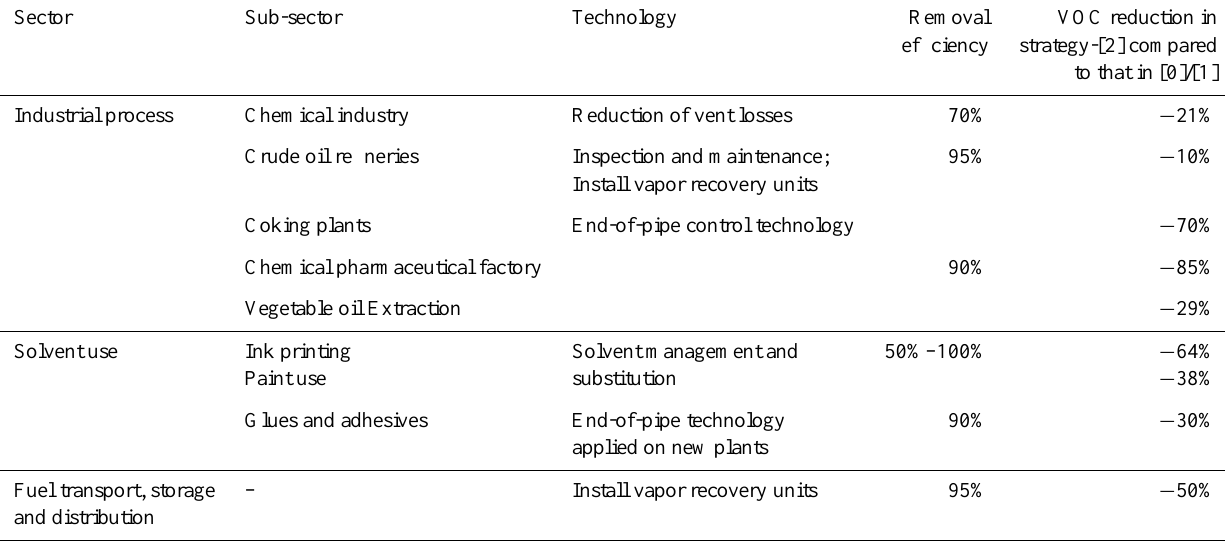
Table 5. Penetration of selected NMVOC control technologies in industry and